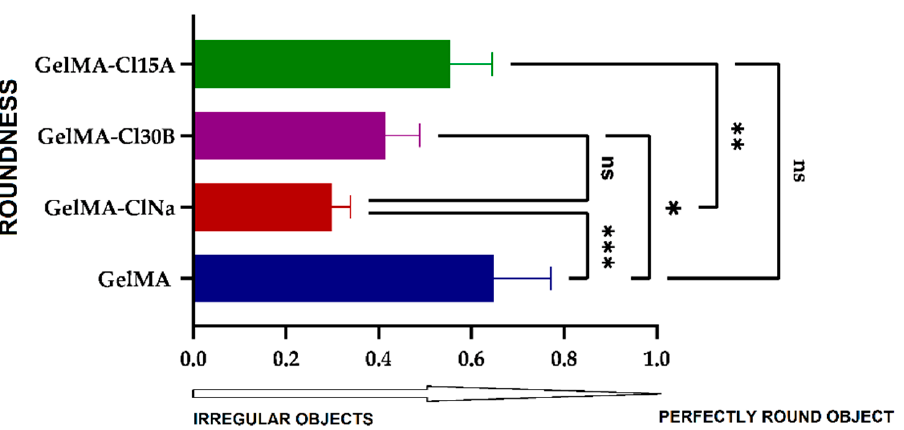
Figure 14. The roundness of open pores calculated for GelMA and GelMA-based 3D printed scaffolds. Statistical significance: ns p < 0.5; * p < 0.05; ** p < 0.005; *** p < 0.0005.